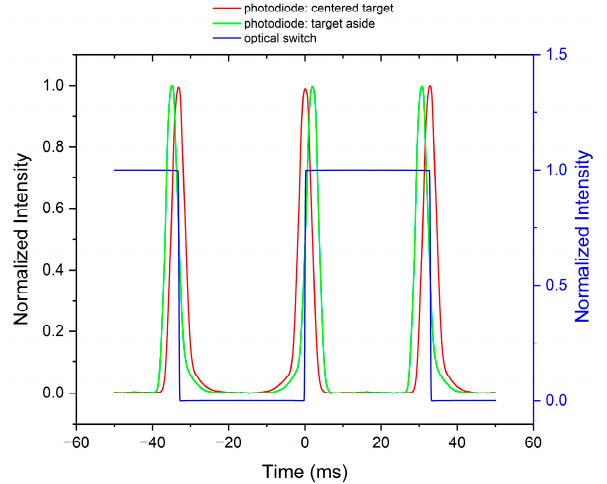
Figure 9. Normalized signals observed with P2 (Picoscope 4424, mean of 100 samples @ 1 MHz). Photodiode signals: target at central position (red) or 1 mm aside (green); digital switch (blue). The resolution was investigated similarly to P1. The best achieved was 1.67 µ m at a target distance of 218 cm (Figure 10), which was significantly smaller than P1.